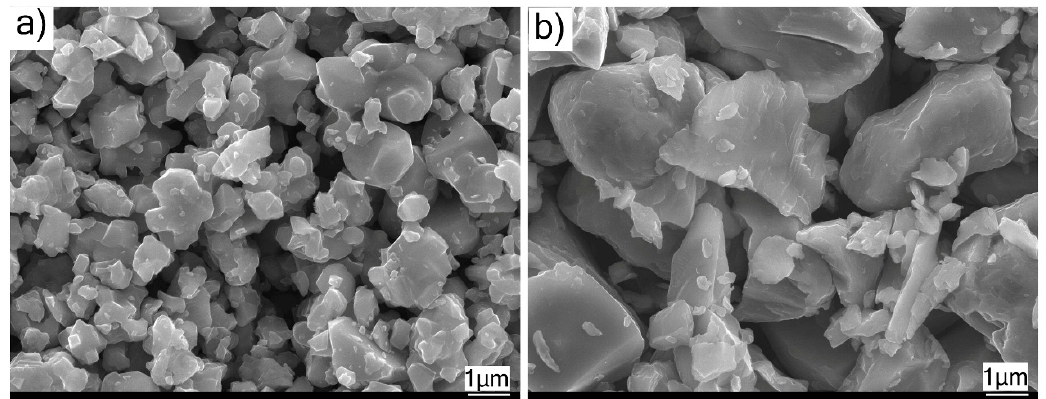
Figure 3. SEM micrographs showing§; ( a ) feedstock TiC powder; ( b ) feedstock Cr 3 C 2 powder.